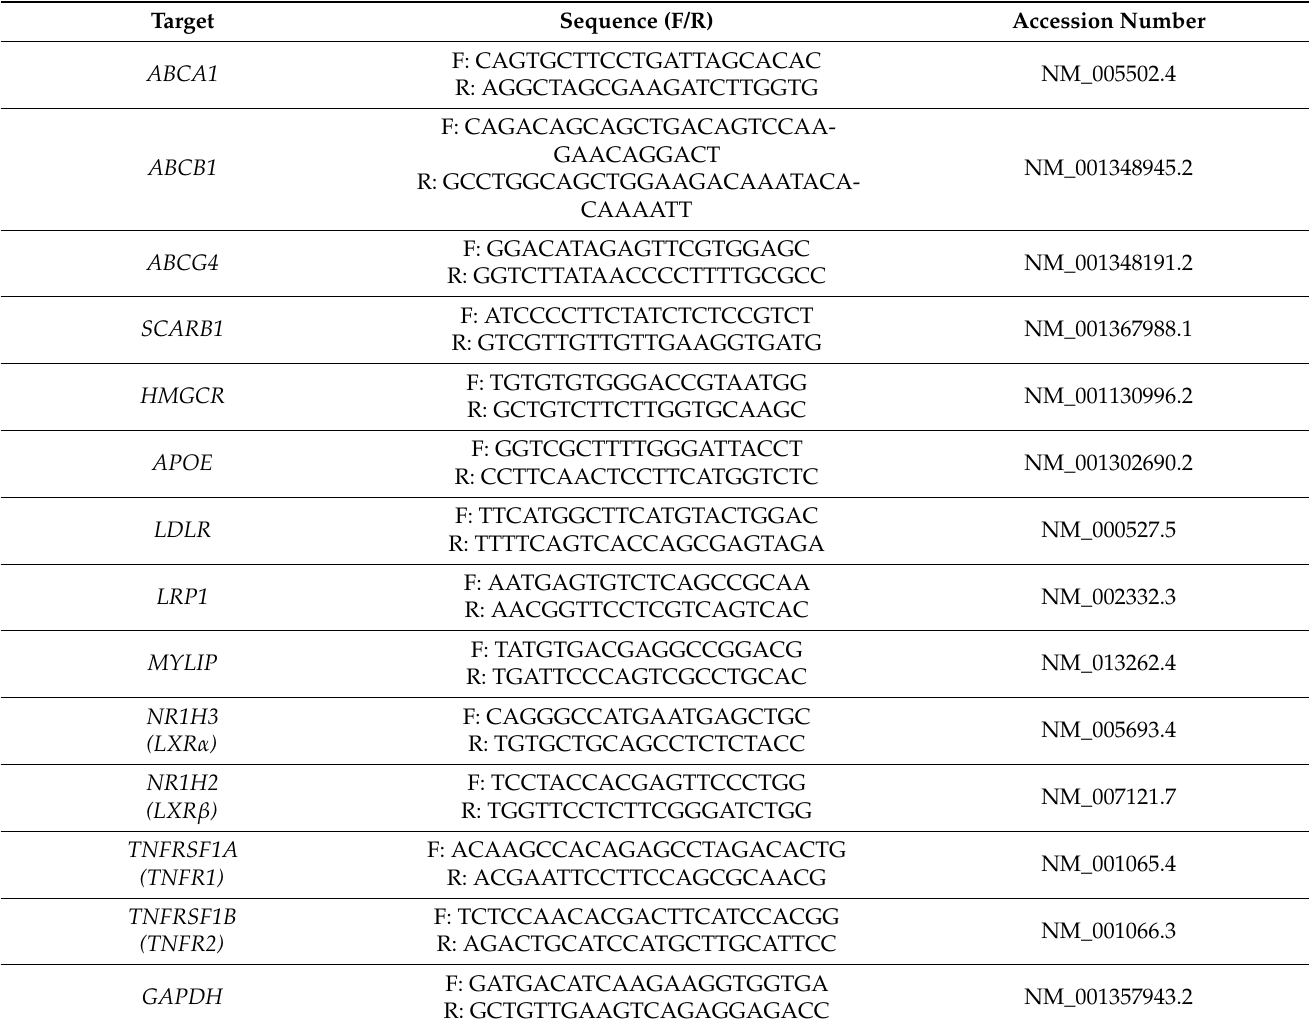
Table 1. Primers sequences for qPCR. Primer pairs: F: forward primer and R: reverse